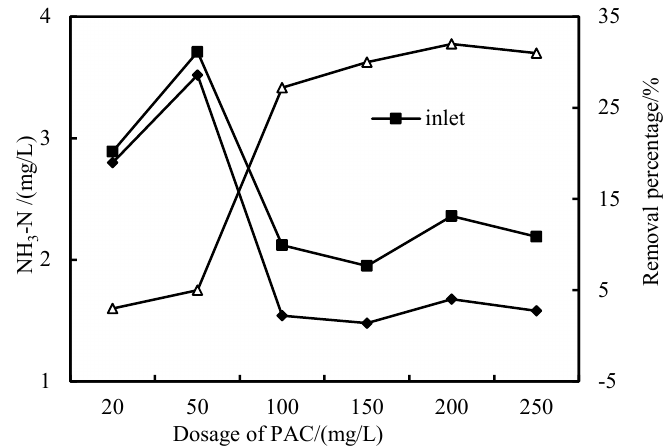
Figure 8. Removal effect of NH 3 -N with PAC